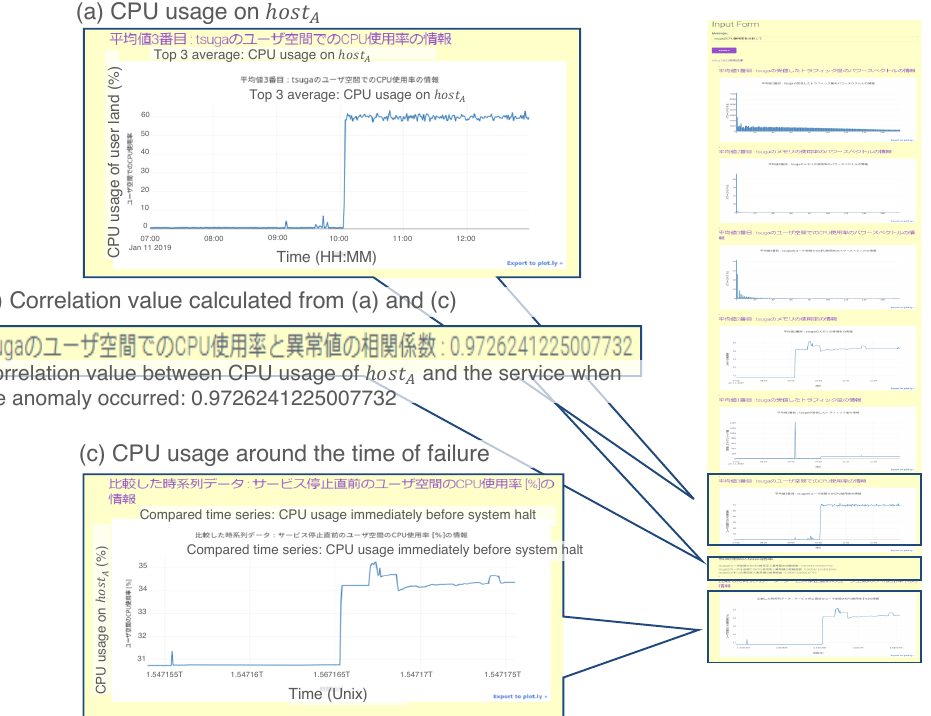
Figure 16. Example result for the prototype system in Case 5. We assert three remarkable results: ( a ) CPU usage on host A , ( b ) correlation value calculated from ( a , c ), and ( c ) CPU usage around the time of the anomaly